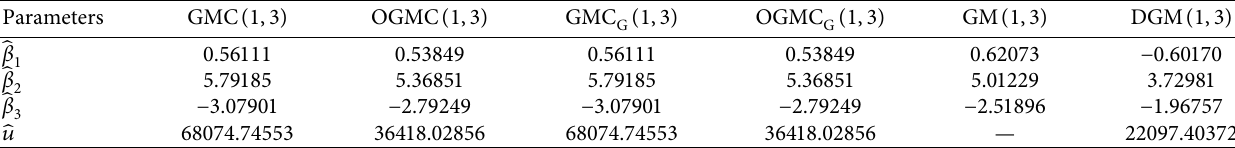
Table 5: Estimated parameter values of six competing models in case two. Parameters